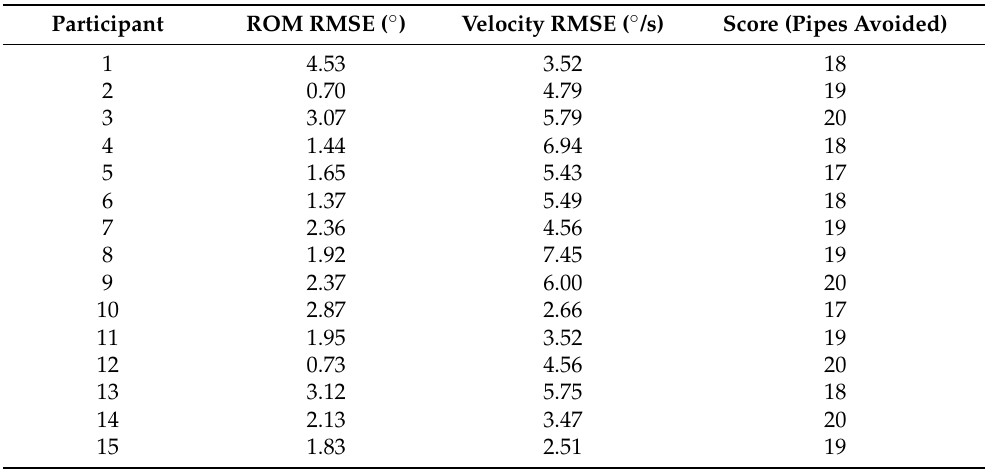
Table 4. Summary of exergame results, including ROM and velocity RMSE and game score broken down by